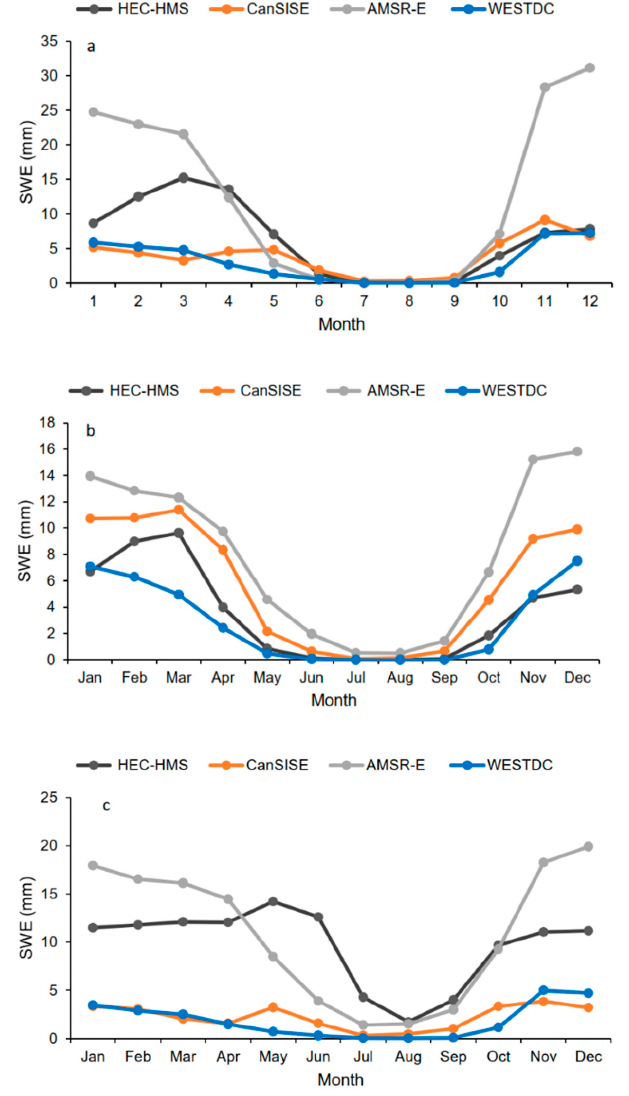
Figure 11. Comparison of SWE simulated by HEC-HMS with CanSISE, AMSR-E, and WESTDC data in ( a ) the SLR, ( b ) SYER, and ( c ) SYAR.